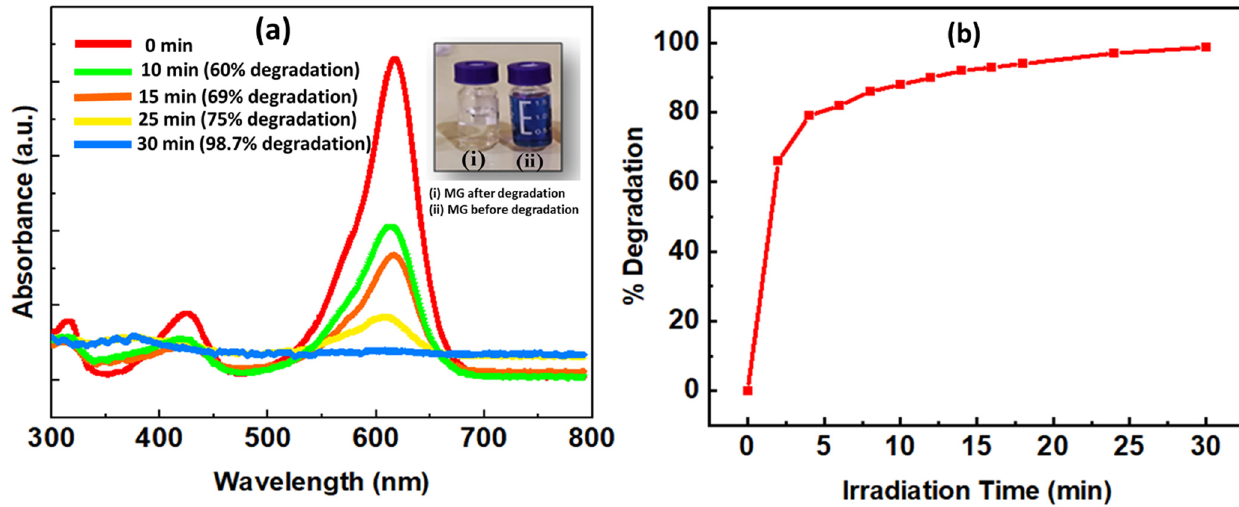
Figure 7. ( a ) UV spectra of N, W co-doped TiO 2 NPs showing organic molecule degradation within 30 min of treatment under solar light, ( b ) effect of irradiation time on percent degradation of MG.